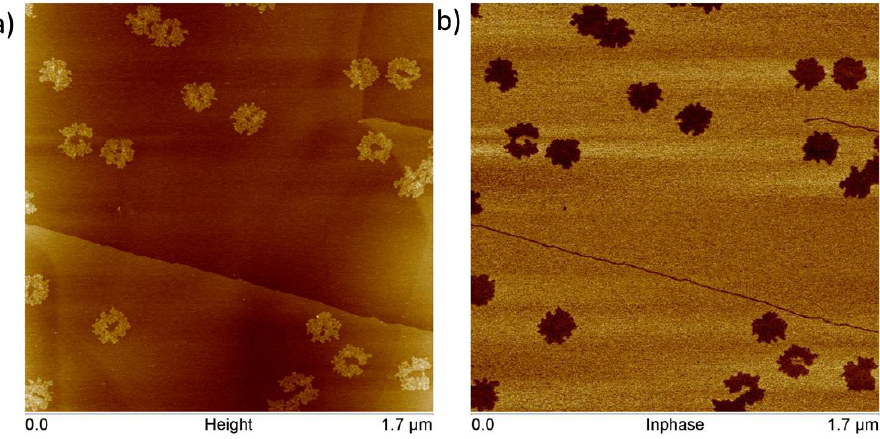
Figure 5. Simultaneously acquired AFM topography ( a ) and in-phase ( b ) images of cDO E deposited onto HOPG.